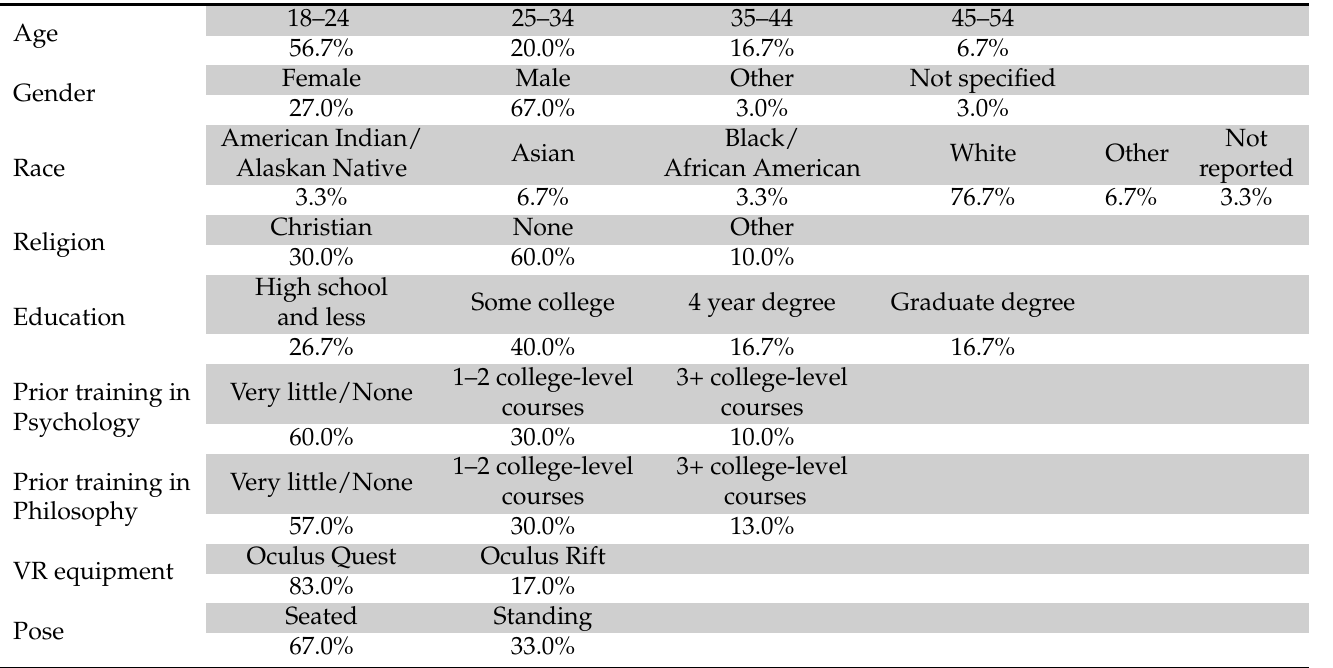
Table 1. Demographics: prior experience in psychology and philosophy, VR equipment used, and pose of the participants during the experiment ( n = 30).